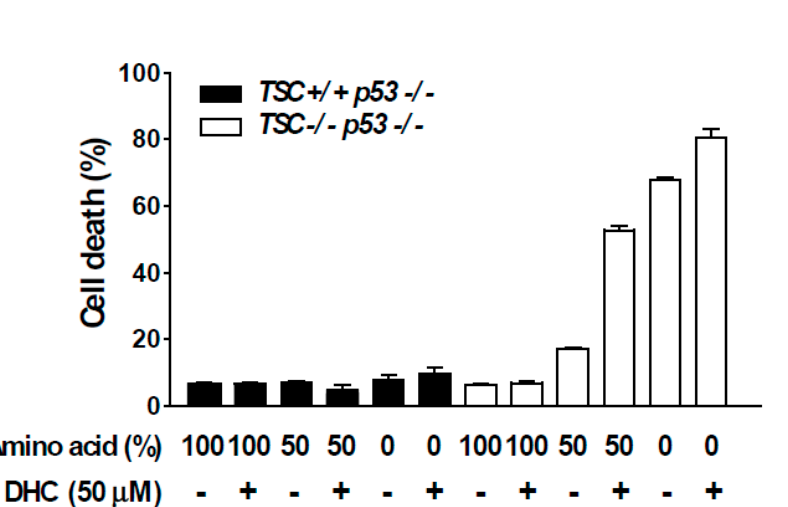
Figure 4. E ff ect of dihydrocapsaicin on amino acid signaling. ( A ) TSC2 − / − , p53 − / − MEFs were treated as indicated for 30 min and lysed for immunoblot analysis. Media was changed to a serum-free media when dihydrocapsiain was added. ( B ) TSC2 +/+ , p53 − / − MEFs were incubated with amino acid-deprived and dialyzed-FBS containing media for 5 h to provide amino acid starvation. Dihydrocapsaicin was pre-treated for 1 h and cells were subsequently re-stimulated with amino acid, using media containing amino acid and regular FBS for 1 h. TSC2 − / − , p53 − / − MEFs were serum starved overnight and then incubated with amino acid-deprived and serum-free media for 5 h. Dihydrocapsaicin was pre-treated for 1 h and cells were subsequently re-stimulated with amino acid, using serum-free media containing amino acid for 1 h. ( C ) Immunofluorescence was performed to examine the translocation of mTOR in TSC2 − / − , p53 − / − MEFs. Mechanistic targets of rapamycin (mTOR) is shown in green and the lysosomal marker, lysosomal-associated membrane protein 1 (LAMP1) is shown in red. DAPI (4 (cid:48) ,6-diamidino-2-phenylindole) is shown in blue. ( D ) 24 h after seeding, media was changed to regular growth media, or media with reduced amino acid content as indicated. Cell death was measured 48 h after changing the media.